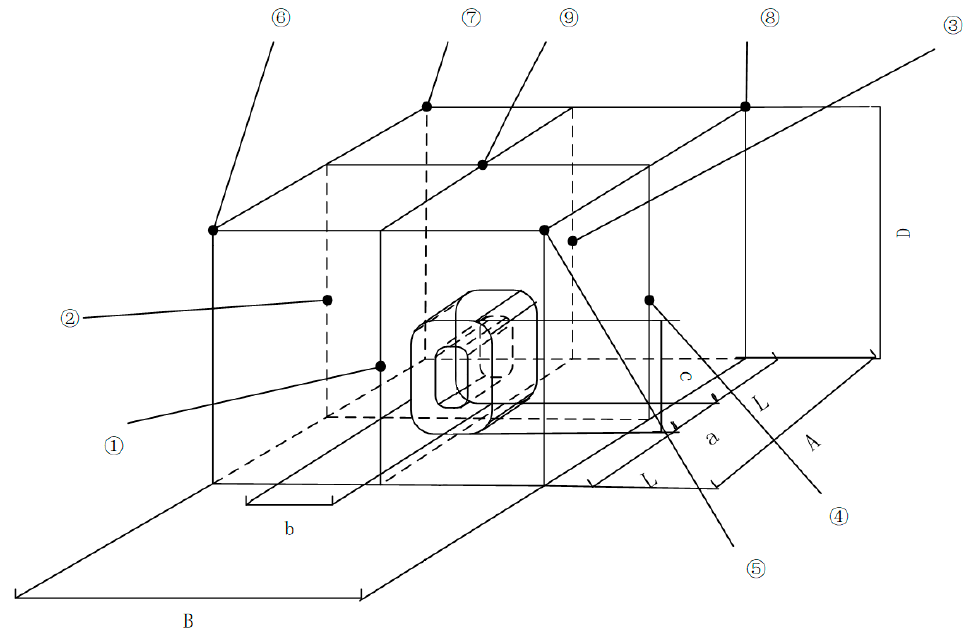
Figure 5. Distribution of noise measuring points. In the picture, a = 142 mm, b = 200 mm, c = 260 mm, L = 300 mm, A = 142 + 300 + 300 = 742 mm, B = 200 + 300 + 300 = 800 mm, D = 260 × 2 = 520 mm.